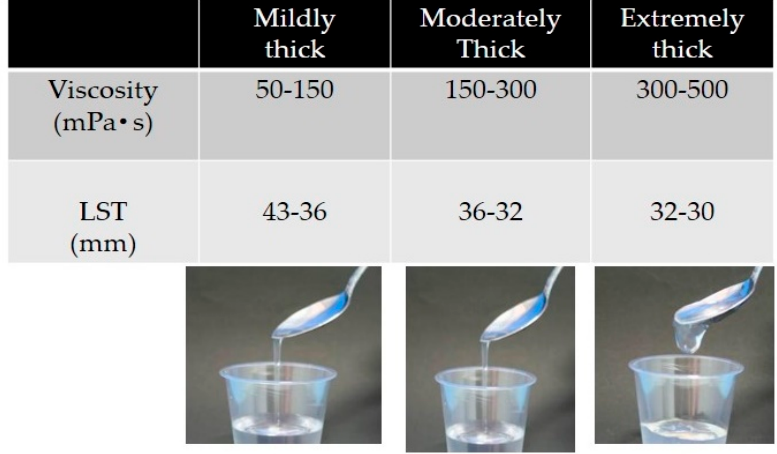
Figure 11. Criteria of thickened liquids (Viscosity obtained share rate 50 sec − ) LST: line spread test.